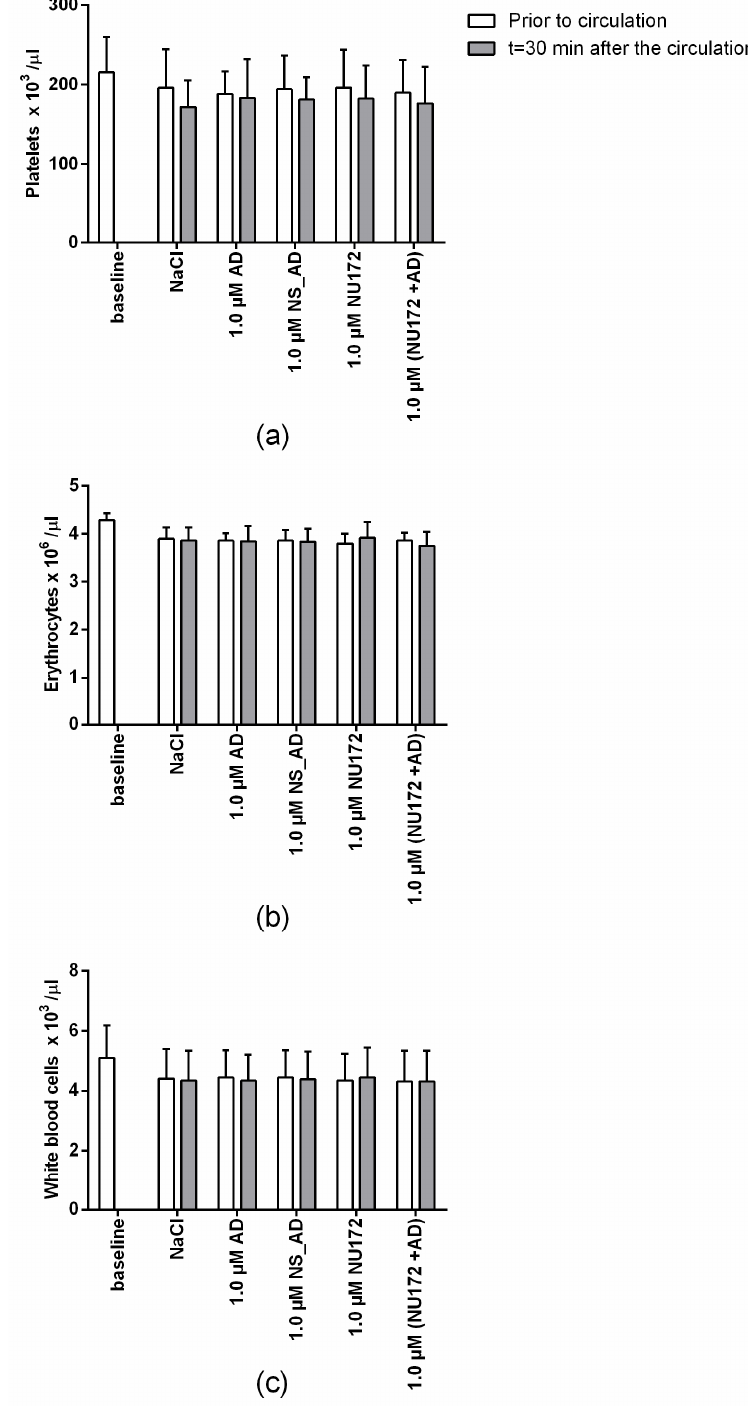
Figure 9. Blood cell count analysis of heparinized blood before and after the incubation in an in vitro rotation model. Heparinized blood was incubated for 30 min at 37 °C with 1.0 µM NU172 or 1.0 µM NU172 and 1.0 µM AD. Blood without any addition was indicated as a baseline. ( a ) Platelets, ( b ) erythrocytes, and ( c ) white blood cell counts are shown (n = 5 ± SD).